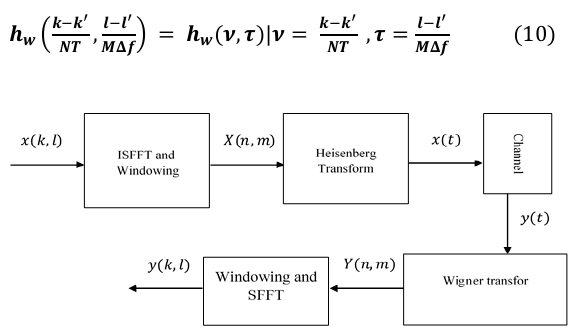
Figure 1 : OTFS modulation